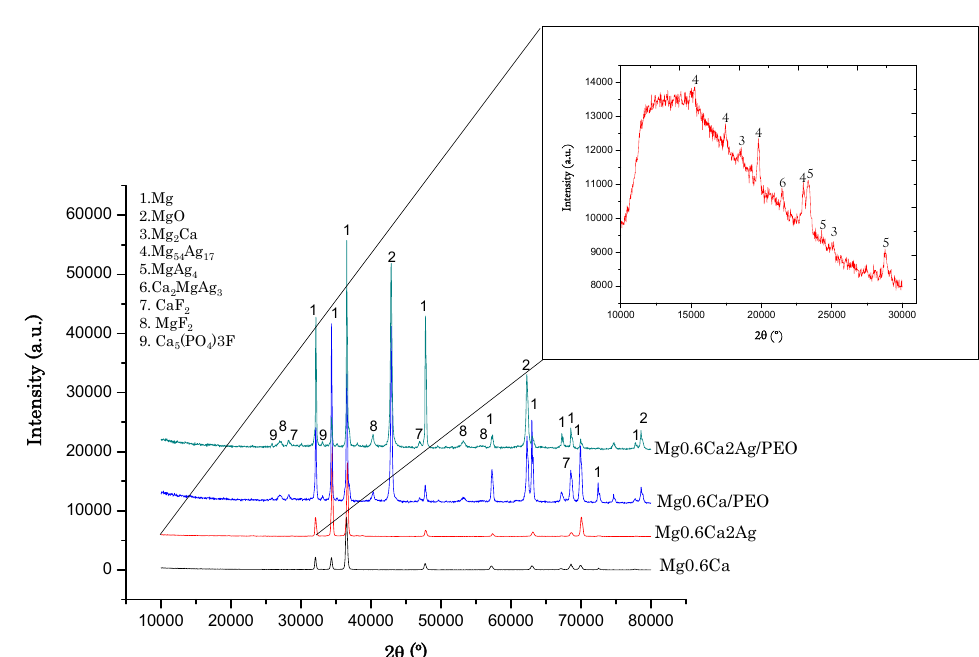
Figure 7. XDR patterns from bulk material and PEO coatings.